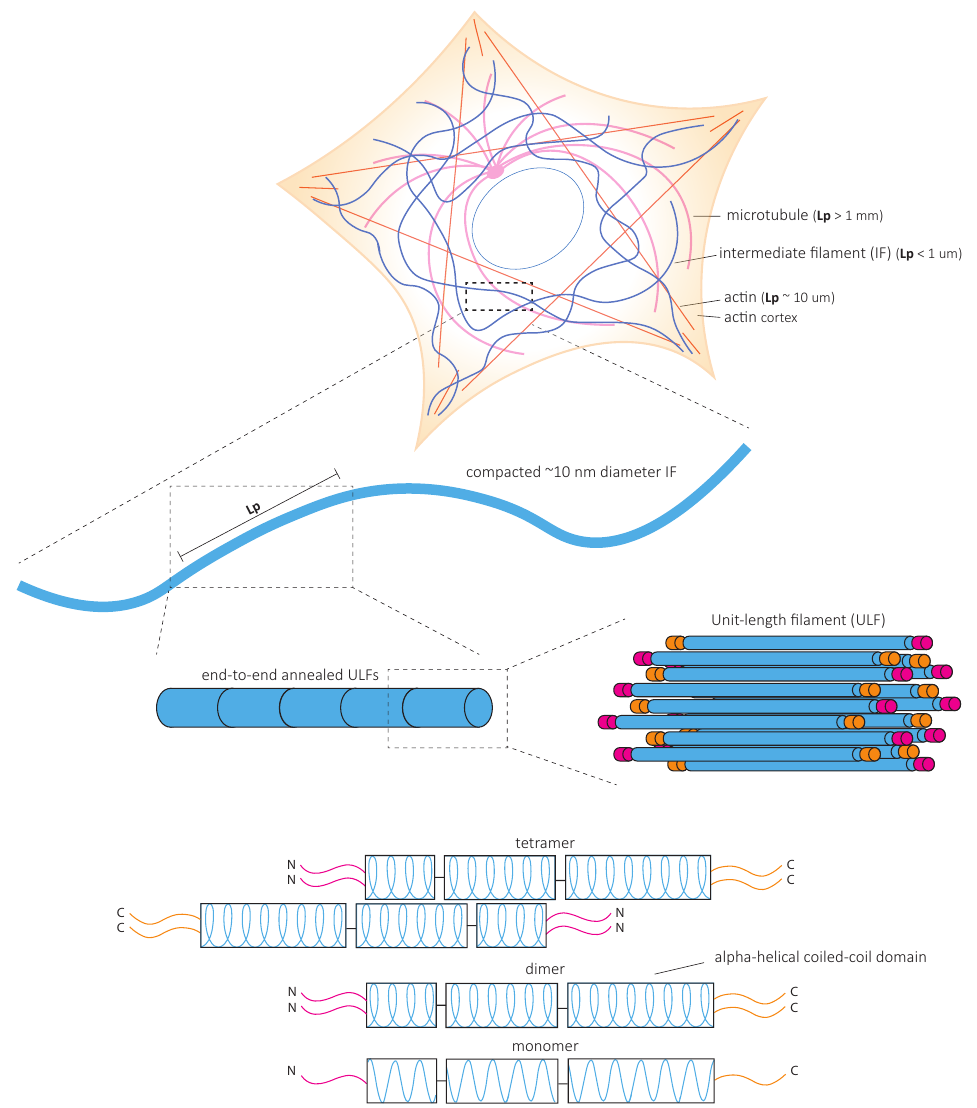
Figure 3. Intermediate filament structure. All intermediate filament (IF) proteins are formed by an α -helical ‘rod’ domain flanked by unstructured N- and C-termini that extend out of the assembled filament. The rod domain contains three coiled-coil domains responsible for the formation of IF dimers [51]. Dimers assemble in an anti-parallel fashion into apolar tetramers. Tetramers assemble via lateral associations into a unit length fragment (ULF) that anneal longitudinally and eventually form long 10 nm diameter filaments after lateral compaction. Soluble IF tetramers contribute to subunit exchange [52–57] and may influence the stability of the filaments and the mechanical properties of the network [57]. Lp = persistence